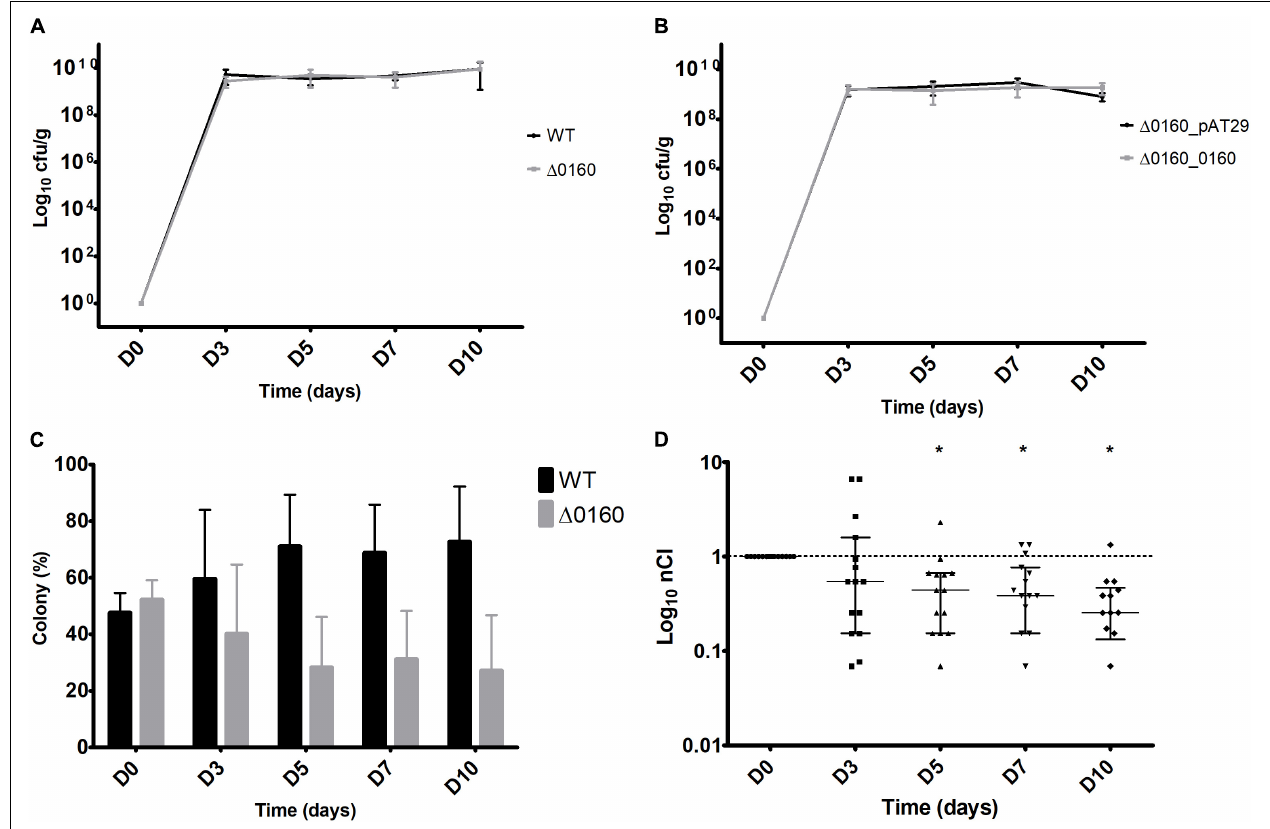
FIGURE 5 | GIT colonization with each strain individually and co-colonization with WT and (cid:49) 0160 strains mixed. (A) Mean bacterial load per gram in fecal pellets from 15 mice inoculated with the WT strain, and 15 mice with the (cid:49) 0160 strain. (B) Mean bacterial load per gram in fecal pellets from mice inoculated with mutant strains (cid:49) 0160_0160 and (cid:49) 0160_pAT29. Error bars represent standard deviation. (C) Proportion of colonies of each strain identified by PCR colony. Each mean value represents the mean colony proportion from 15 mice (12 PCR at each time point for each sample). (D) Normalized competitive index (nCI) values calculated for each mouse represented with means and 95% confidence interval. Asterisk indicates which results have been shown by statistical analysis to be different from